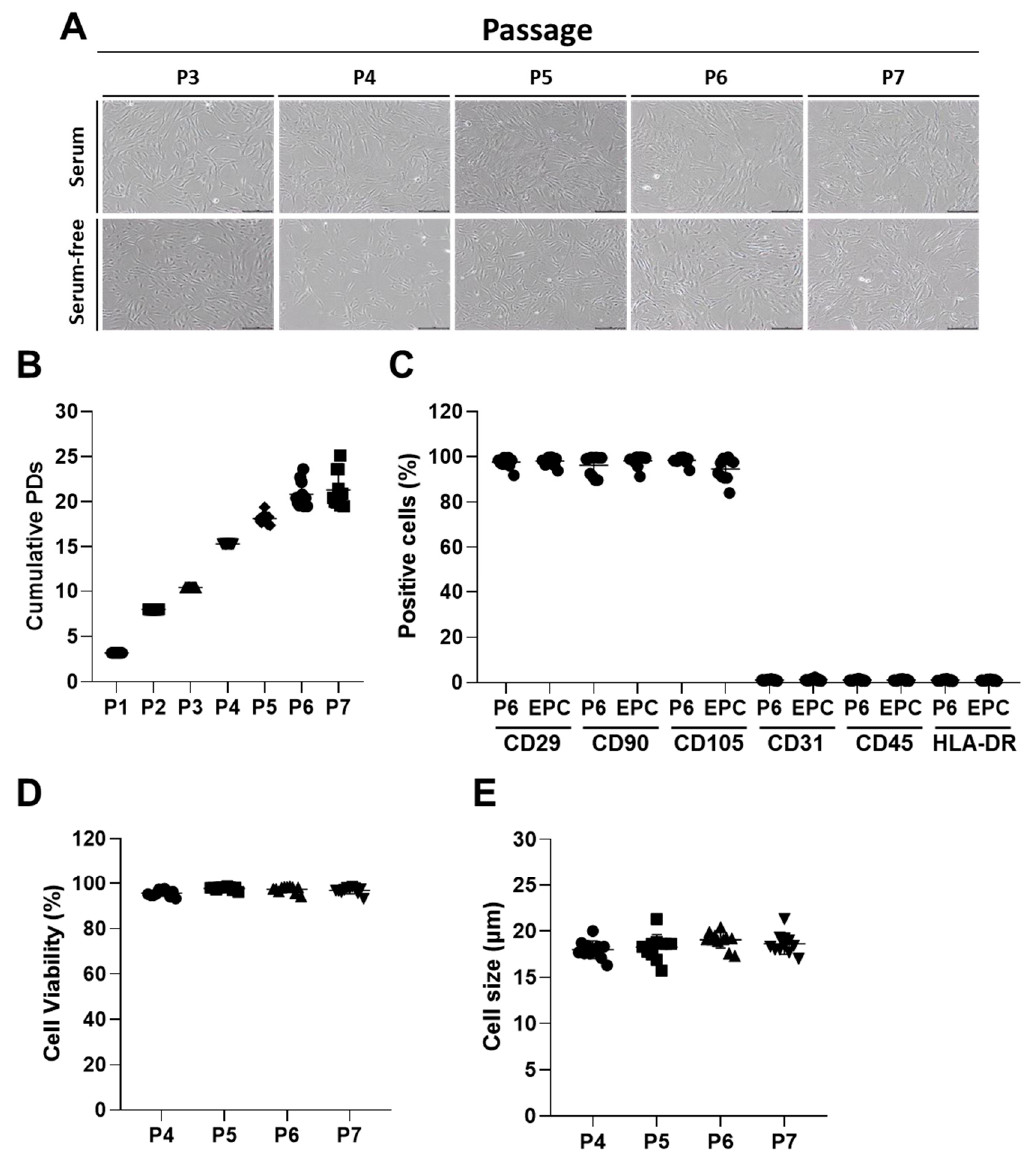
Figure 2. Characteristics of human ASCs over time. ( A ) The morphology of cultured ASCs over time. Scale bar = 200 μ m. ( B ) Cumulative population doublings (PDs) of ASCs from the culture of different repeats ( n = 11). ( C ) The levels of surface markers over time ( n = 11). ( D ) Viability and ( E ) size of ASCs over time ( n = 11).